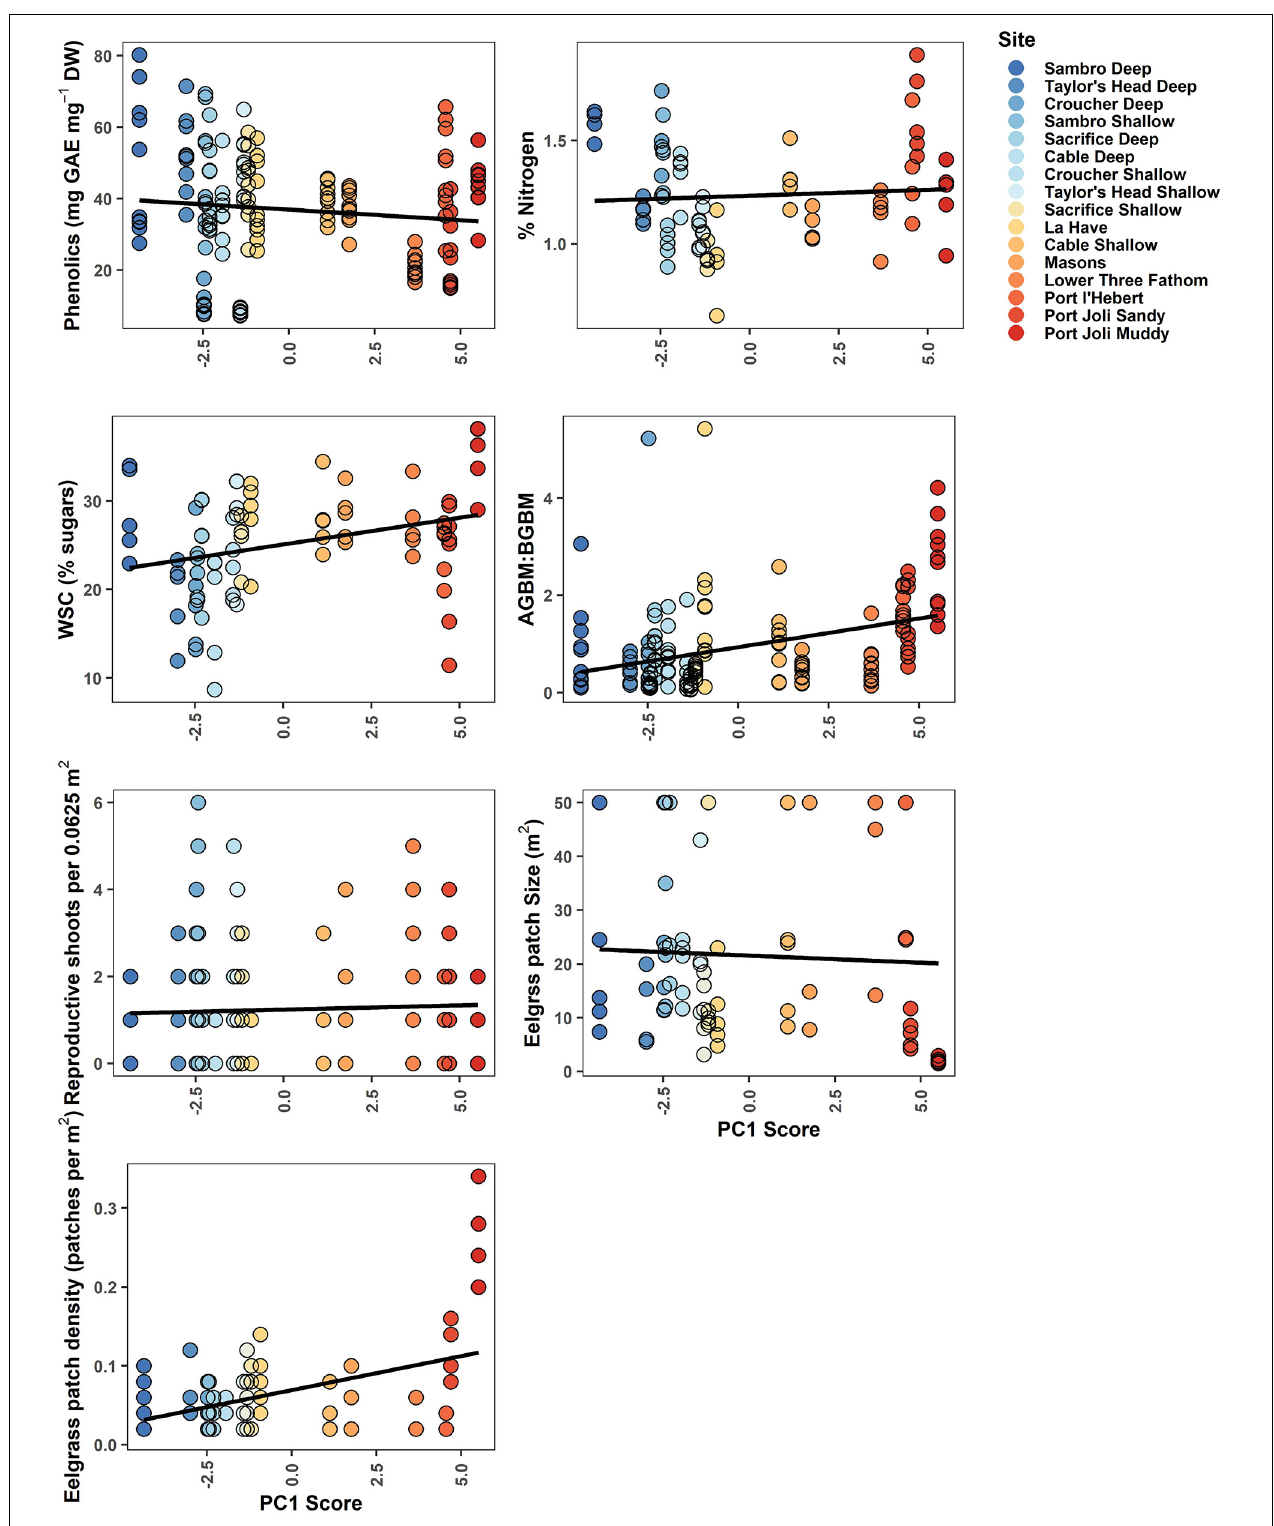
FIGURE 5 | Biological metrics of resilience plotted against each site’s score along the first principal component in the PCA of environmental variables. WSCs were measured in rhizomes, while % Nitrogen was measured in leaves. The least-squares fit straight line is given in black. Point color corresponds to Figure 2 , demonstrating a gradient from cooler, deeper sites (blue) to warmer, shallower sites with higher light attenuation (red).